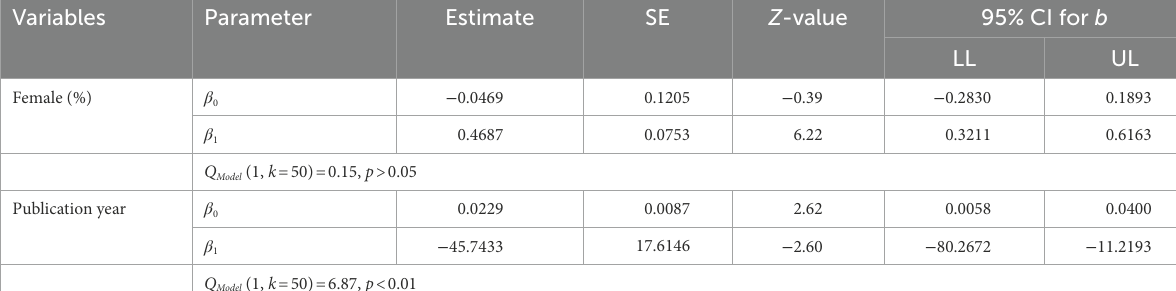
TABLE 4 Meta-regression analysis of gender and publication